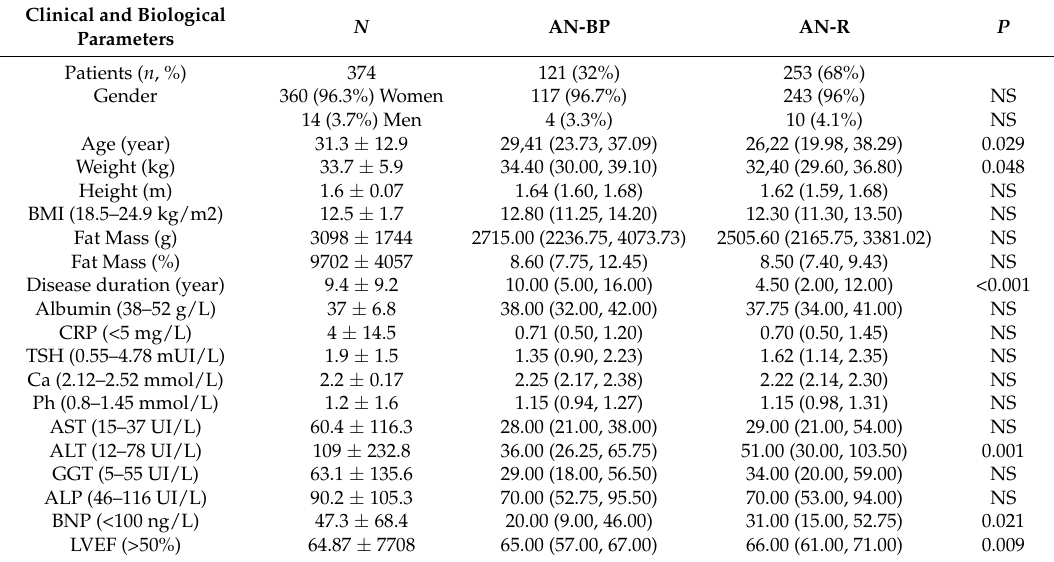
Table 1. Characteristics of all patients at admission and comparison between Anorexia Nervosa restricting type (AN-R) and AN binge-purging (AN-BP). Clinical and Biological N AN-BP AN-R P Parameters Patients ( n , %) 374 121 (32%) 253 (68%)